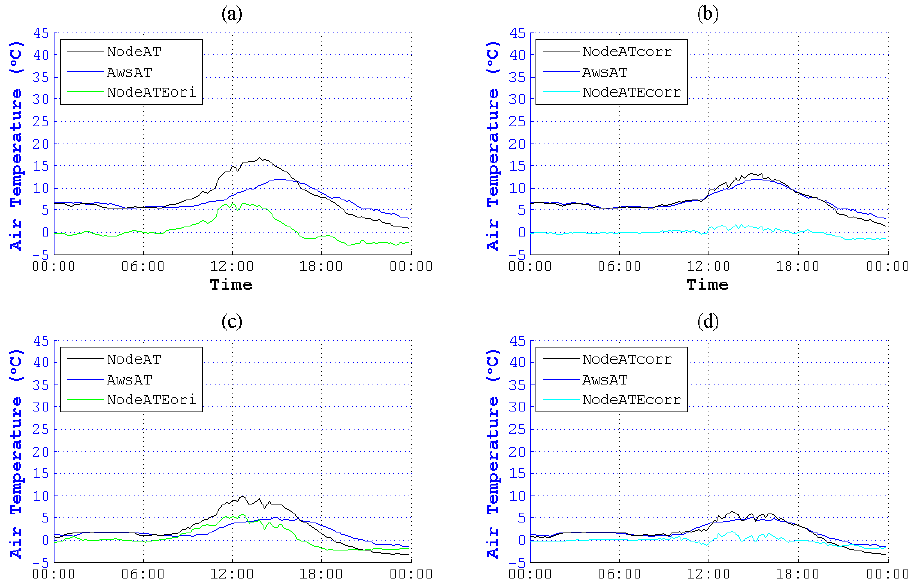
Figure 17. Contrast of NodeAT and NodeATcorr on 7 December 2014 and 21 December 2014. ( a ) Original data on 7 December 2014; ( b ) corrected data on 7 December 2014; ( c ) original data on 21 December 2014; ( d ) corrected data on 21 December